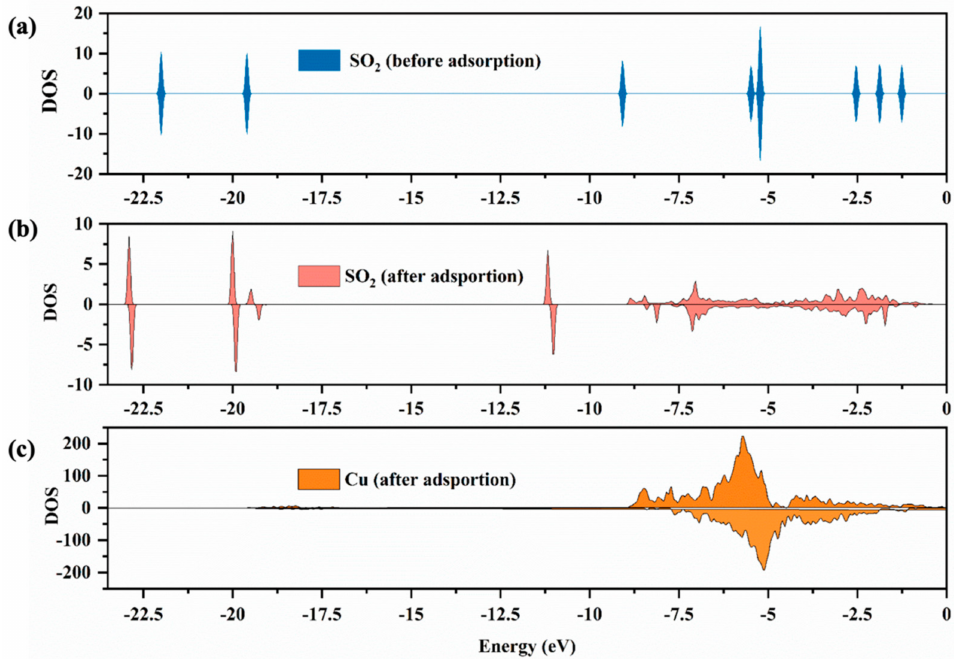
Figure 5. The DOS for SO 2 molecules ( a , b ) and Cu atom ( c ) before and after adsorption, where the Cu atom is Cu on the surface of CuO. The Fermi energy corresponds to